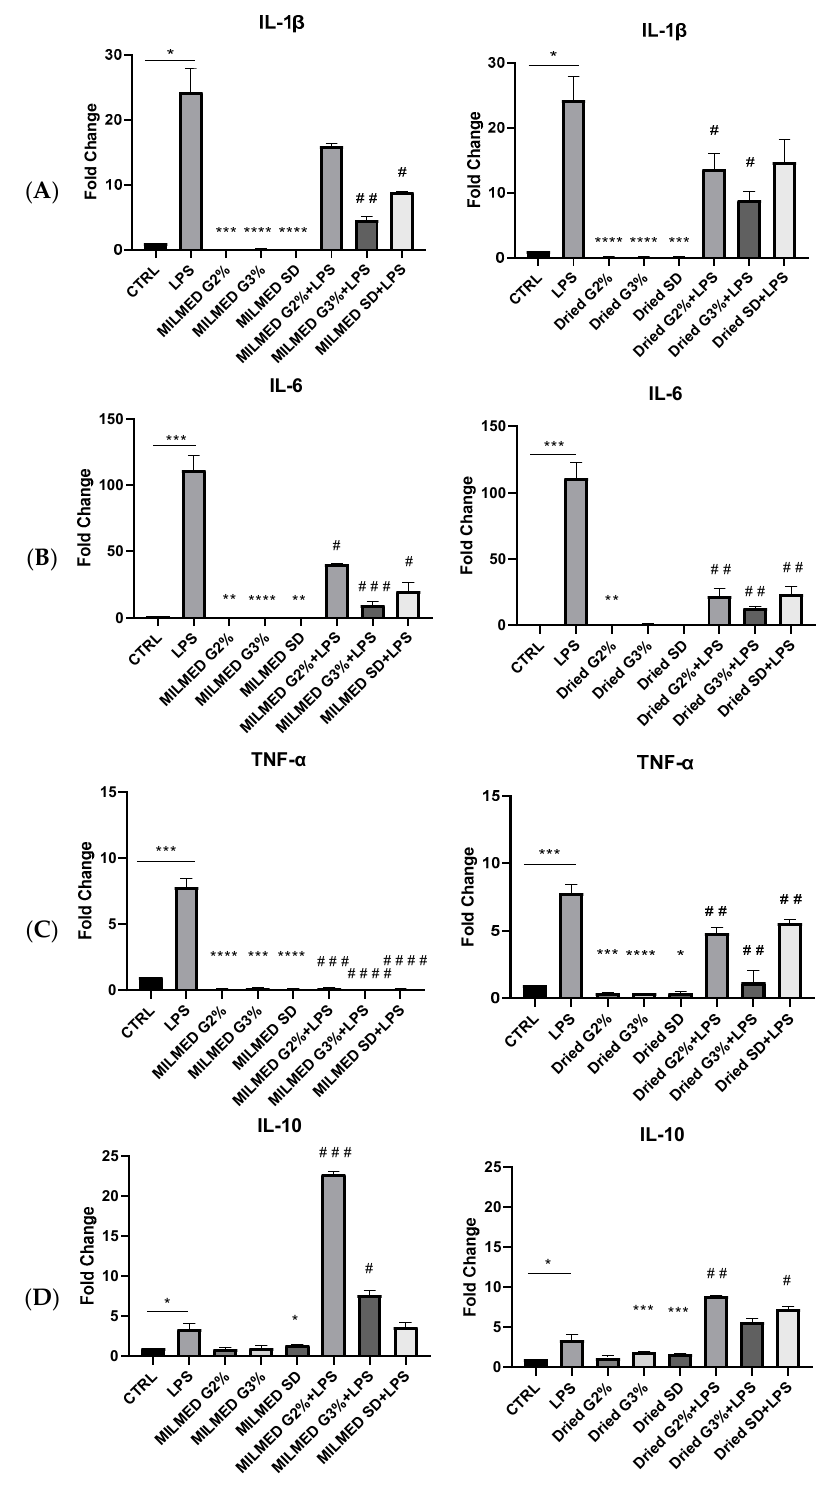
Figure 4. mRNA expression of ( A ) interleukin-1 β ( IL-1 β ); ( B ) interleukin-6 ( IL-6); ( C ) Tumor Necrosis Factor- α (TNF-a); and ( D ) interleukin-10 ( IL-10); monitored by qRT-PCR and normalized to β -actin. The decrease of mRNA expression of pro-inflammatory cytokines is associated with increased mRNA expression of IL-10 in BV2 cells in both Milmed and Dried treatment. Data are shown as mean ± SD from three independent experiments performed in triplicate. Expression profiles were determined using the 2 − ∆∆ CT method. Statistical analysis was evaluated by unpaired Student’s t test. * p < 0.05, ** p < 0.01. *** p < 0.001, **** p < 0.0001; ## p < 0.01; ### p < 0.001; #### p < 0.0001 * VS CTRL, # VS